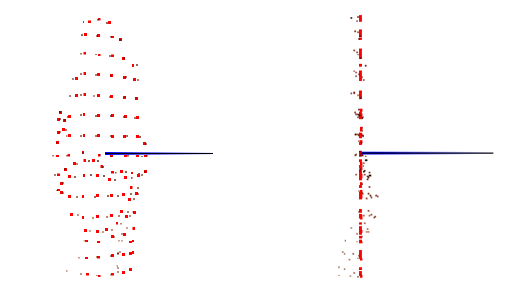
Figure 7: Approximation of a palm plane from a point cloud. Red points are inliers of the approximated plane. The blue line is the normal vector of the